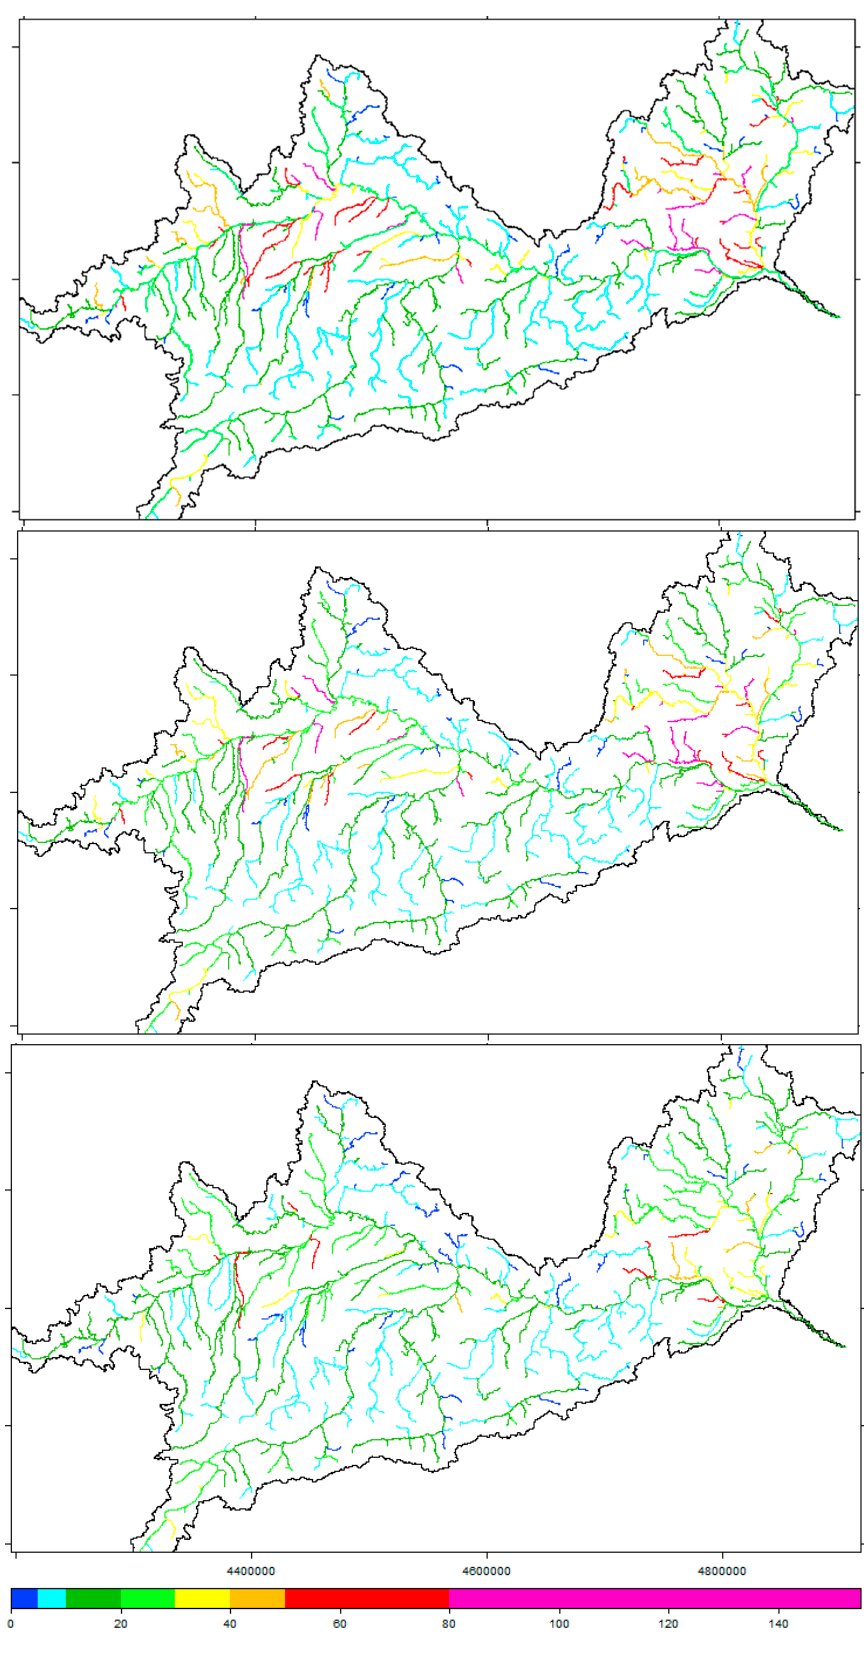
Figure 9. Reach average monthly N ‐ NO 3 concentration (mgN/L) for 15 ‐ year simulation period in the Upper Danube Basin under three catchment management strategies: ( top ) BLS; ( middle ) SmartFert; and ( bottom ) OptiG.